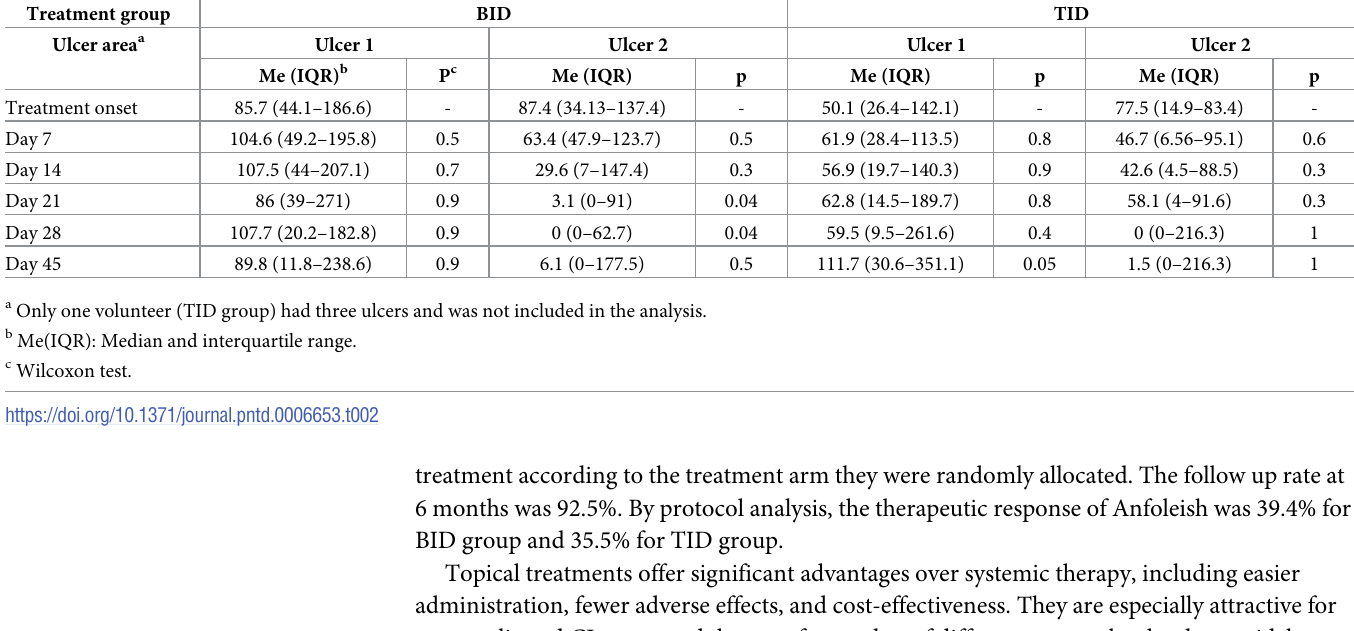
Table 2. Change in the ulcer area during follow-up respect onset treatment in who failed (exploratory analysis). Treatment